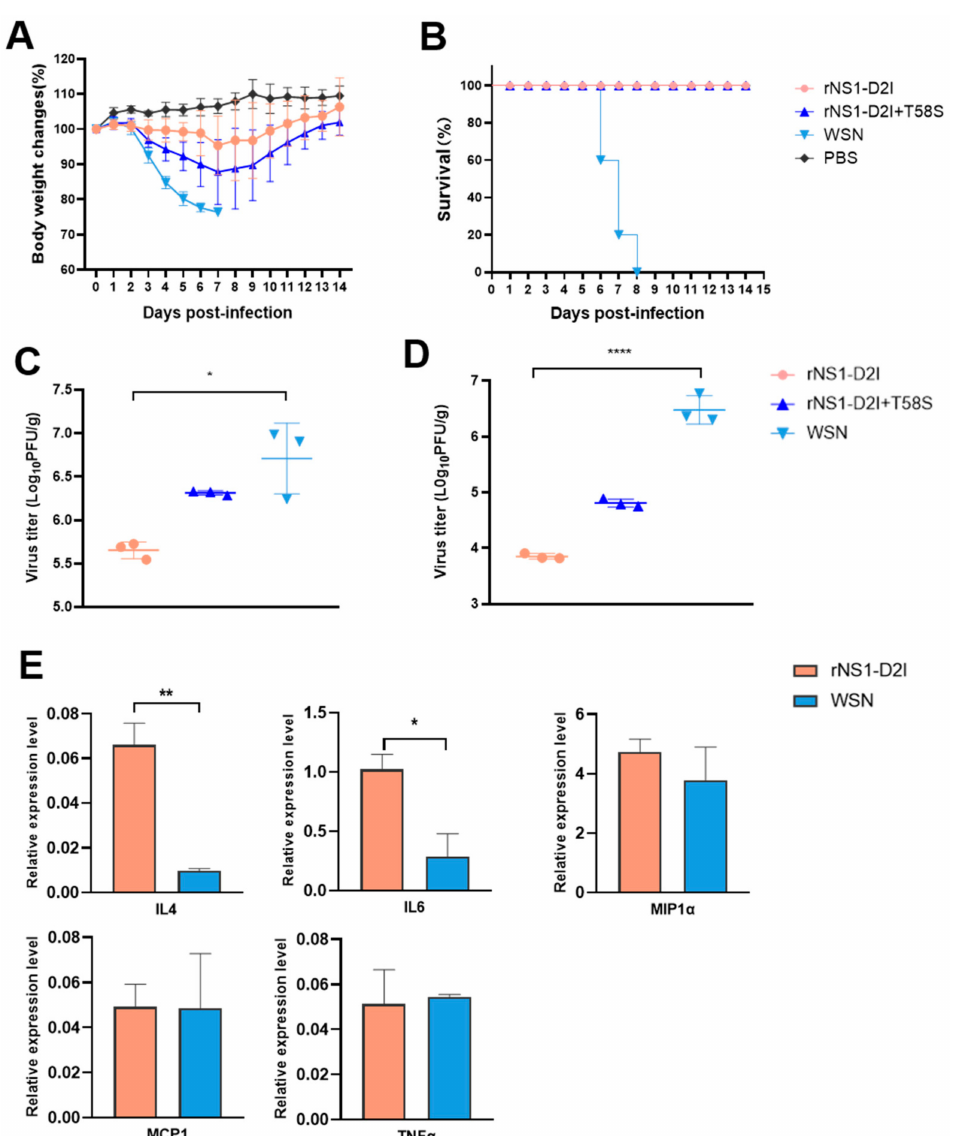
Figure 7. In vivo characterizations of WSN NS1 D2I mutated virus. ( A ) Body weight changes of mice infected with 10 4 PFU of rNS1 D2I, rNS1 D2I + T58S and WSN viruses. ( B ) Survival curves. ( C ) Viral titers in infected mice lungs on 3, and ( D ) 5 dpi. ( E ) The mRNA expression levels of IL-4, IL6, MIP-1 α , MCP-1 and TNF α in BALB/c mice infected with WSN and rNS1 D2I mutant. Infected mice lungs were collected at 3 dpi for cytokine detection by qPCR. Expression levels were normalized to that of GAPDH and are presented as changes (n-fold) in induction relative to the control value. p values were calculated by using the Student’s t -test, * p < 0.05, ** p < 0.01, **** p <